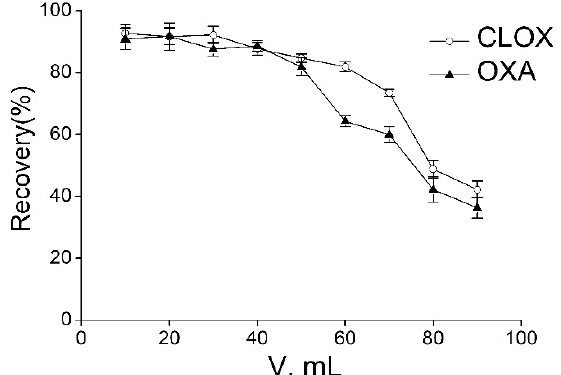
Figure 9. Effect of the extraction volume on the recoveries of analytes. Conditions: the amount of PPy-PA6-NFsM, 10.0 mg; concentration of two analytes, 0.5 µ g / mL; pH, 4.0; eluent, 2.0 mL of 2% ammonia / ACN ( v / v ); desorption time, 30 min.